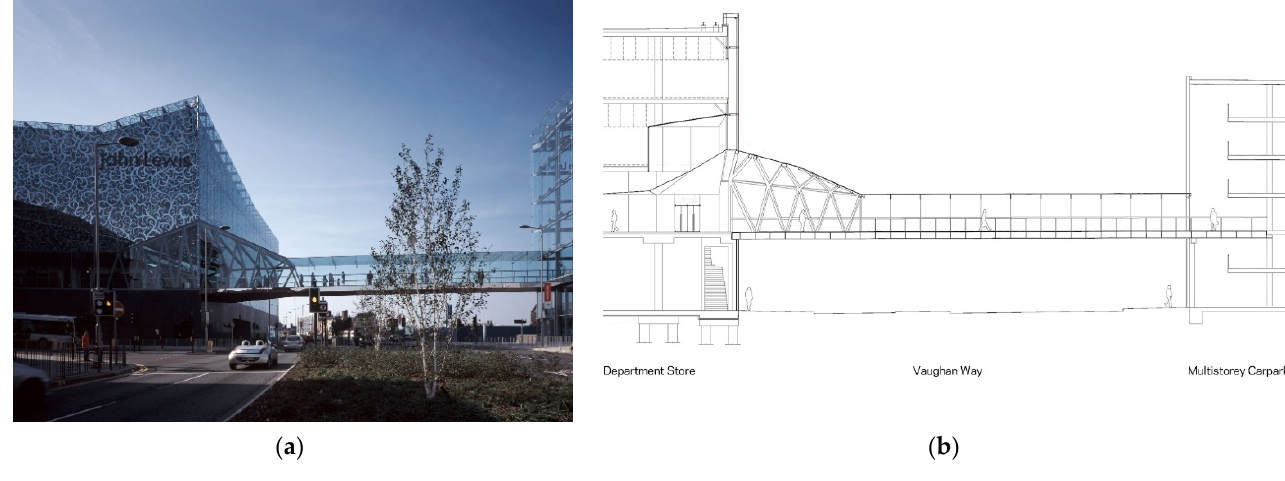
Figure 9. The footbridge at the John Lewis Department Store in Leicester: ( a ) view of the footbridge from the Vaughan Way, (© Satoru Mishima); ( b ) section through building John Lewis Department Store and Parking, (© AZMPL).